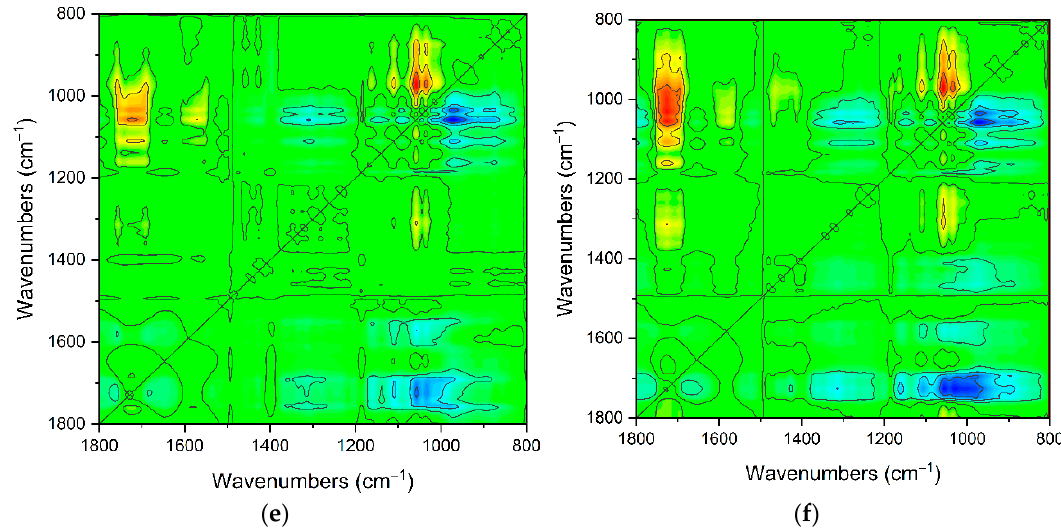
Figure 1. The ATR-FTIR spectra of non-modified bacterial cellulose and its cellulose magnetic composites obtained after modification with the different initial concentrations of CA and types of magnetic particles ( a ) NiFe 2 O 4 , ( b ) MgFe 2 O 4 , and a 2D synchronous and asynchronous spectra for composites with nickel ( c , e ) and magnesium ( d , f ) ferrites ranging from 1800 cm − 1 to 800 cm − 1 . Spectra were normalized regarding band area at 1161 cm − 1 (C-O-C).